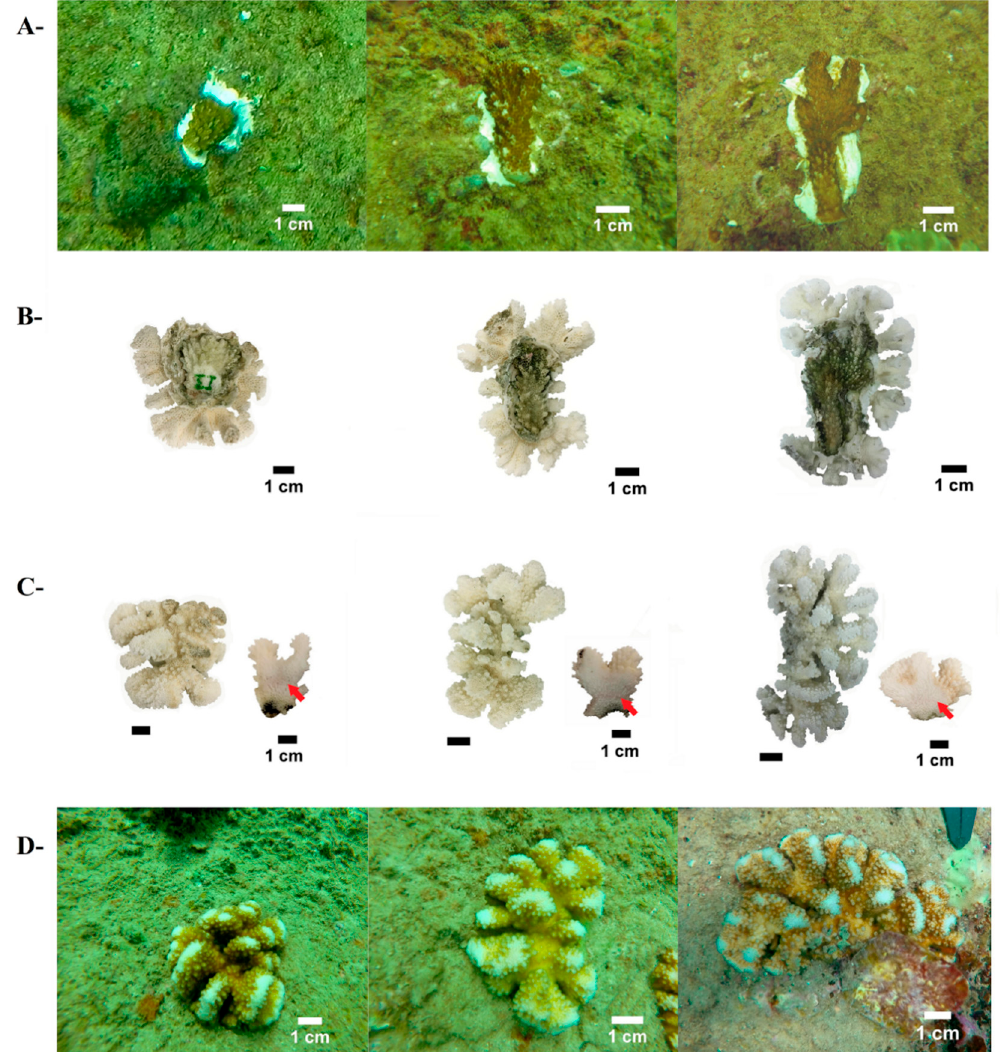
Figure 3. The use of micro-fragments of Pocillopora spp. from Islas Marías Cleofas for coral reef restoration. ( A ): micro-fragments at onset, just glued to the substrates; ( B ): coral skeletons comparing initial and final branches (bottom-side view); ( C ): coral skeleton upside view and coral branch slabs exhibiting Alizarin red marks (red arrows); and ( D ): final coral size of the same colonies as in part A, 13 months later.